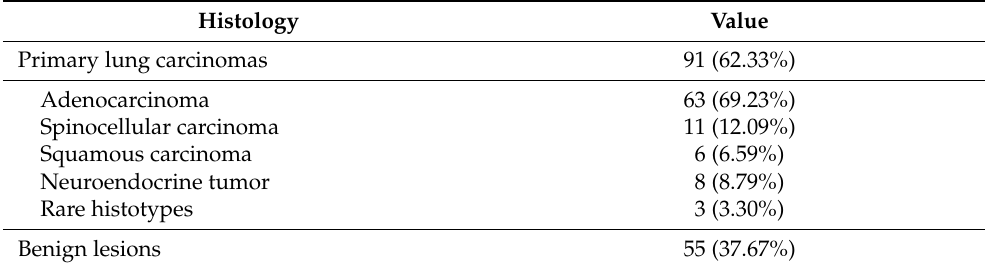
Table 2. Definitive diagnosis of the 146 SPNs.